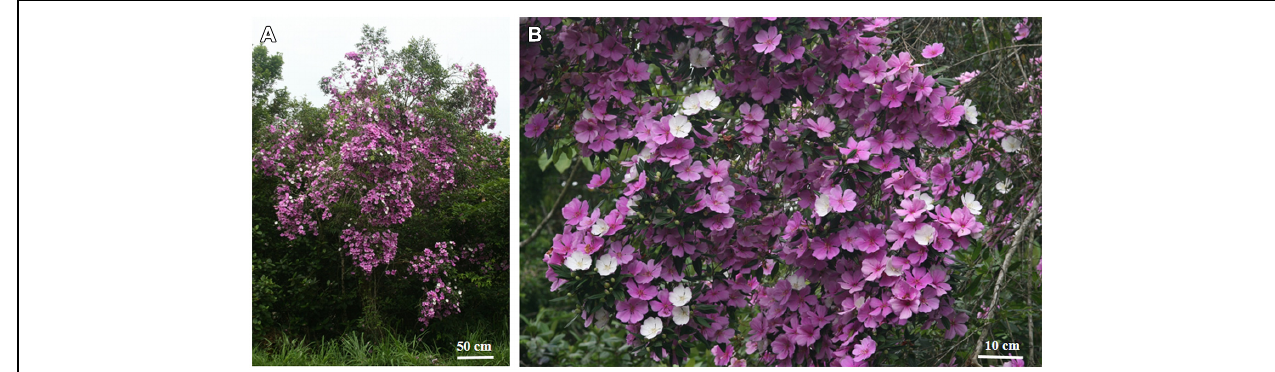
FIGURE 1 | Floral color change and retention of old flowers in Tibouchina pulchra . (A) A T. pulchra tree in flowering peak, covered by old pink flowers, and new white flowers. (B) Close-up showing the pink background made by old pink flowers spotted with new white flowers.